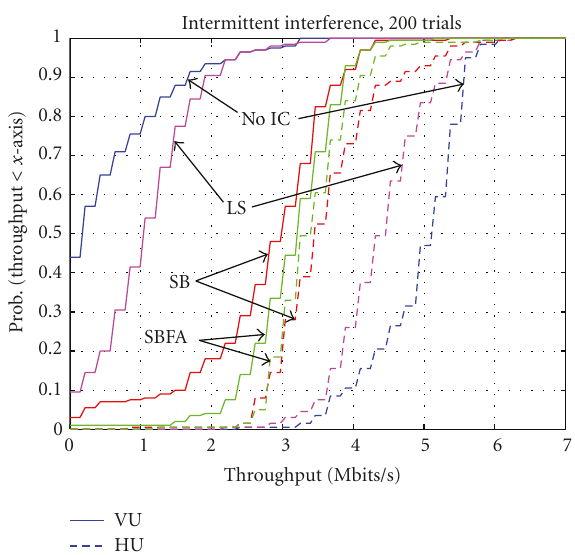
Figure 16: Throughput CDF for residential scenario of Figure 12 with an intermittent intersystem interferer (50%